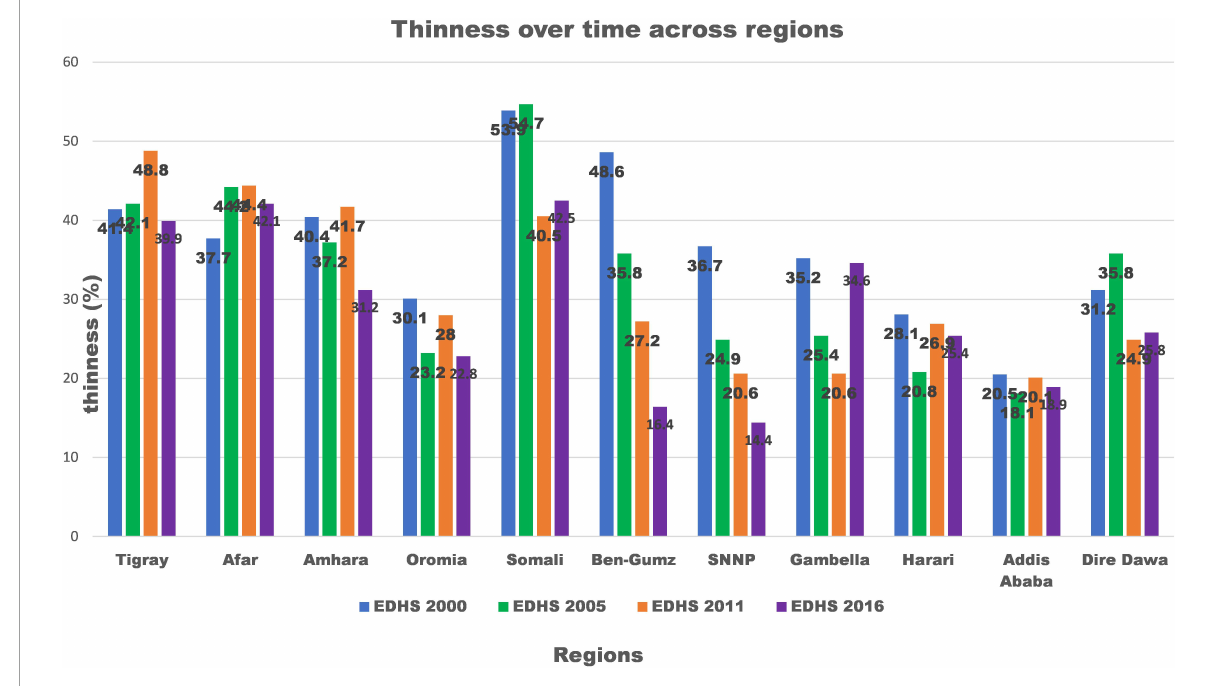
FIGURE2 Trends of thinness among late adolescent girls over time across regions of Ethiopia from 2000 to